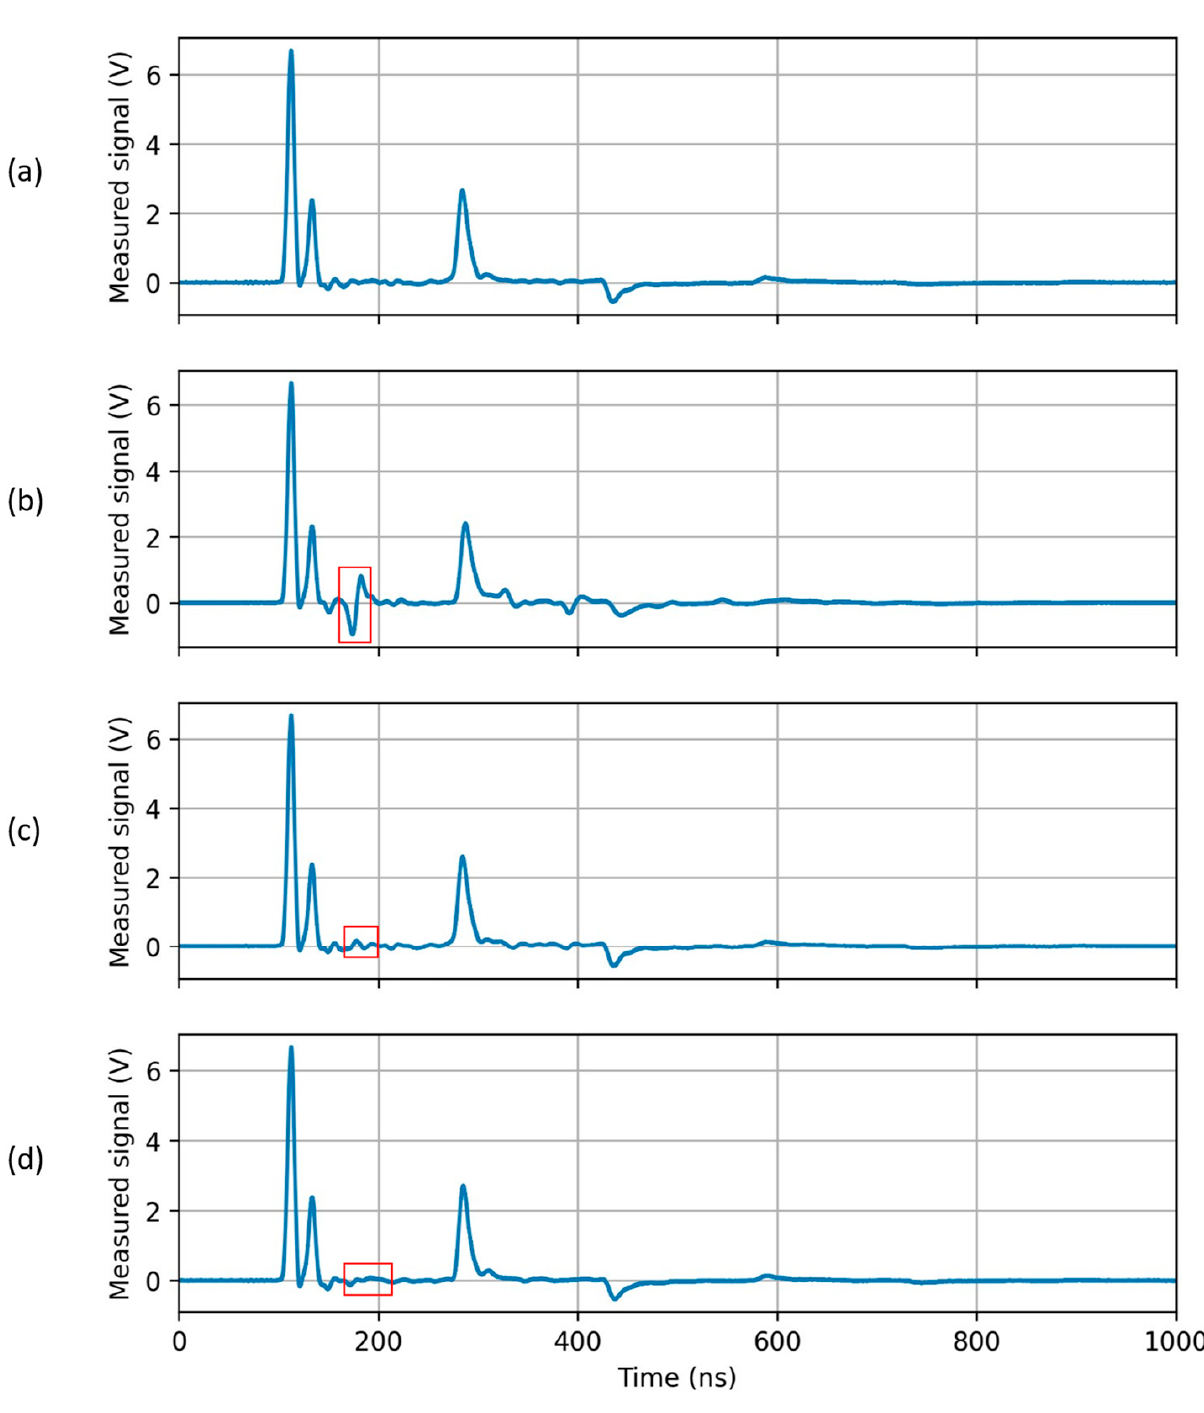
Figure 4. Examples of measured signals, SE length: 15 m. The depicted signals have been obtained in the following conditions: ( a ) SE in absence of water; ( b ) method 1, 33.5 cm long water container; ( c ) method 2, 33.5 cm long water container; ( d ) method 2, 2 m long water container. In each case, the position of the water container is 4 m from the first end of the SE, and the water height is 2 cm in all cases. Reflected pulses corresponding to water-leak conditions are marked with red boxes.